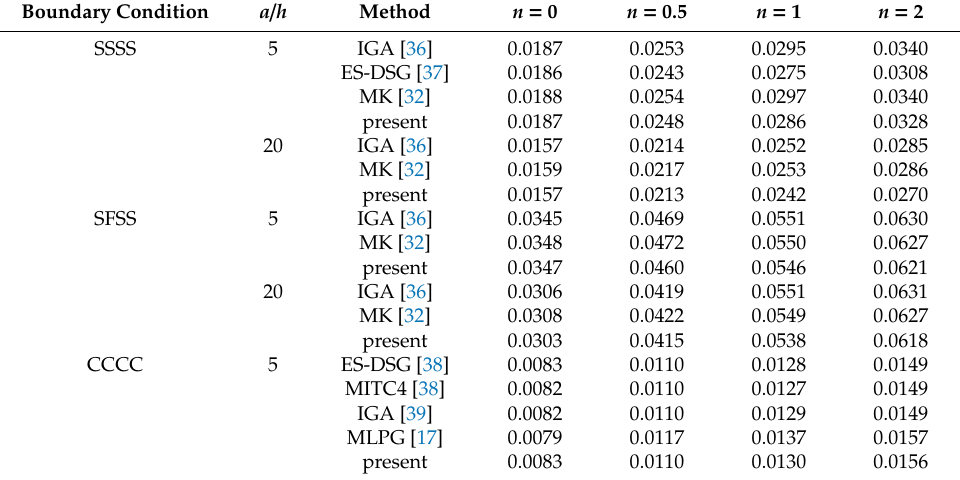
Table 2. Normalized center deflection w ∗ = wE Al h 3 / q of an Al / ZrO 2 square plate with di ff erent length-thickness ratio a / h and gradient index n under the transverse uniform load q